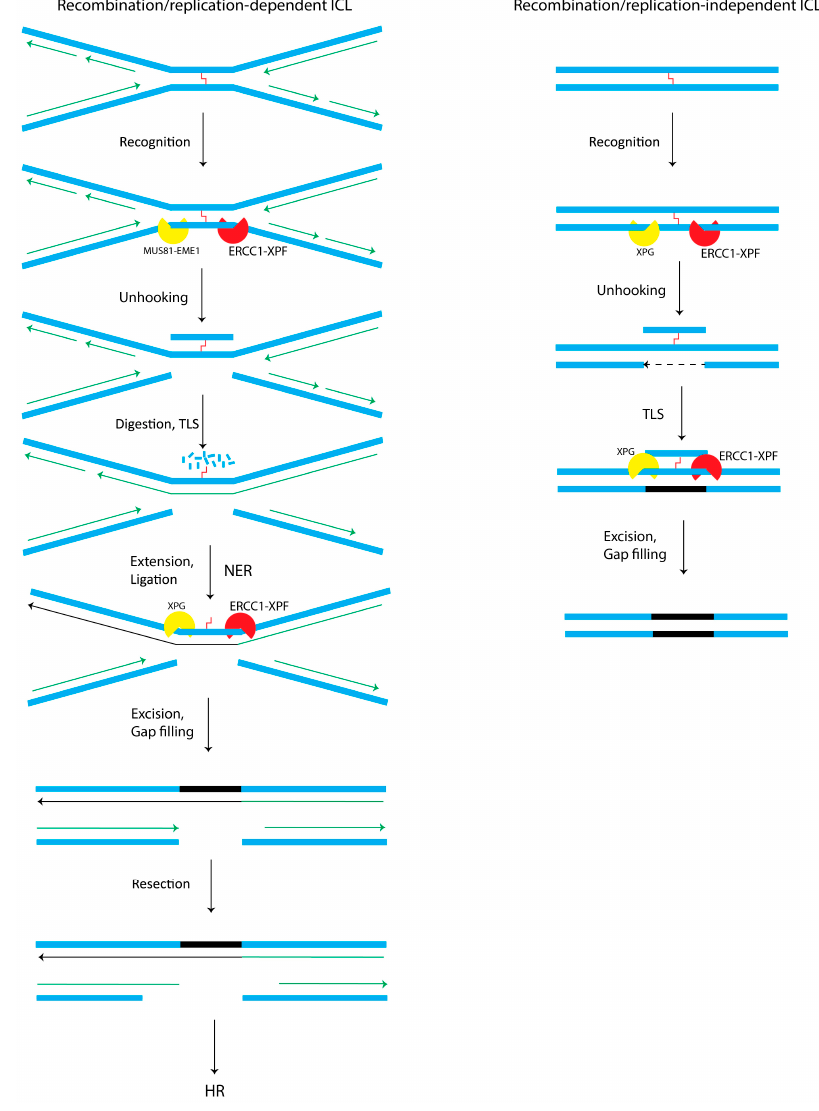
Figure 3. The mechanisms of ICL repair. ICLs cause the replication machinery to collapse at the replication fork (left panel) and create DSBs that cannot be repaired without excising and unhooking at both sides of ICLs, by Mus81-Eme1 and ERCC1-XPF, creating a one-sided DSB. This makes the strand accessible for TLS polymerases that bypass the unhooked crosslink in a mutagenic manner and the final lesion is removed via NER. The created two-sided DSB in the next strand is repaired through homologous recombination (HR). In the right panel, ICLs recognition occurs by stalled RNA polymerase during transcription, initiating TC-NER and ERCC1-XPF function. After the function of TLS, NER factors perform excision on the two sides of ICL, followed by gap filling and continuation of transcription. Adapted from [84] .